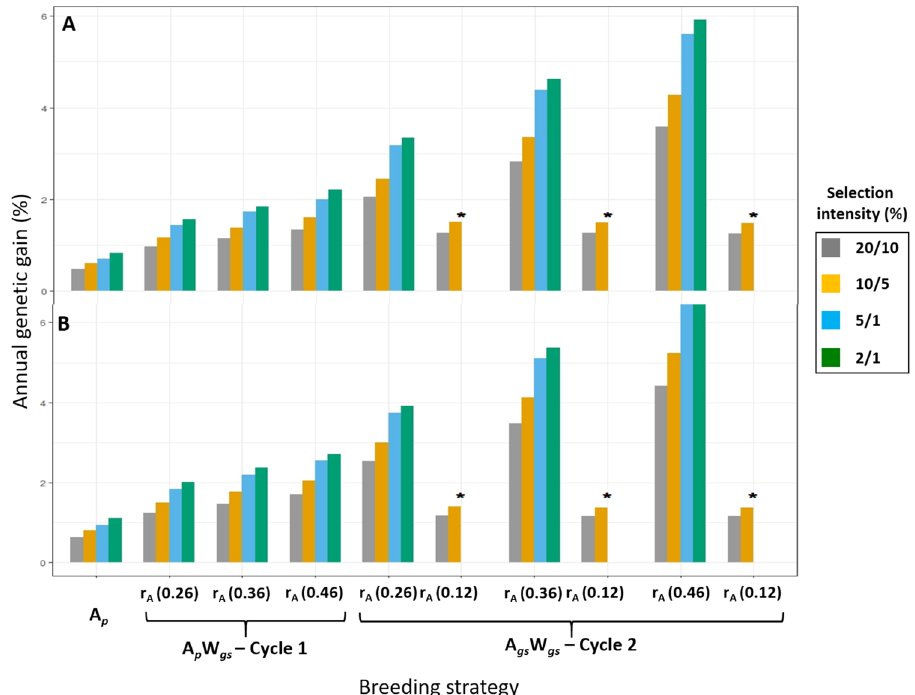
Figure 1. Predicted annual percentage genetic gain (%∆G) for seasonal DM yield resulting from modelling the breeding strategies; among HS family phenotypic selection (A p ), among HS family phenotypic selection and within family genomic selection (A p W gs ), among and within HS family genomic selection (A gs W gs ), applied to the: ( A ) 200 HS families and ( B ) 1000 HS families, of perennial ryegrass. A p was only conducted for one cycle. In cycle 2, only genomic selection (GS) was conducted at accuracies (r A ) of 0.12, 0.26, 0.36 and 0.46. *r A of 0.12 was only applied to simulations using among HS family selection pressures of 20% and 10% and within HS family selection pressures of 10% and 5%, respectively. The predicted annual %∆G for each combination of selection pressures is indicated by the height of bars, values in brackets indicate r A levels. Since cycle 1 consisted of 3 years, annual genetic gain, %∆G = %∆G C /3. Cycle 2 was 1